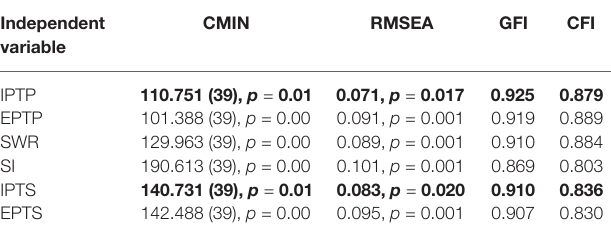
TABLE 2 | Model fits for tested mediation models by the independent variable. Independent